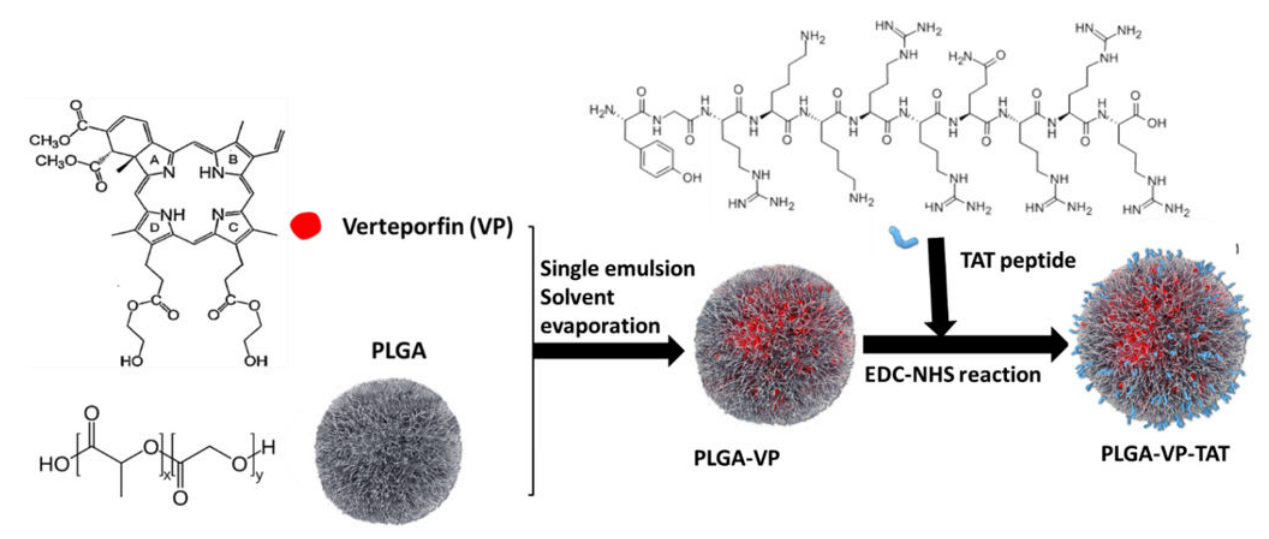
Figure 6. Schematic illustration of PLGA–VP–TAT nanoparticle